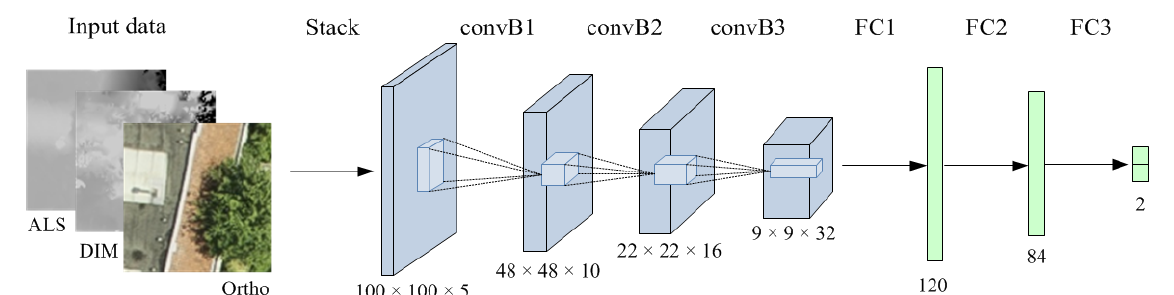
Figure 2. The CNN architecture proposed for multimodal change detection. The top row shows the operations, the parameters below feature maps show the feature map size and number of channels (e.g. 100 × 100 ×